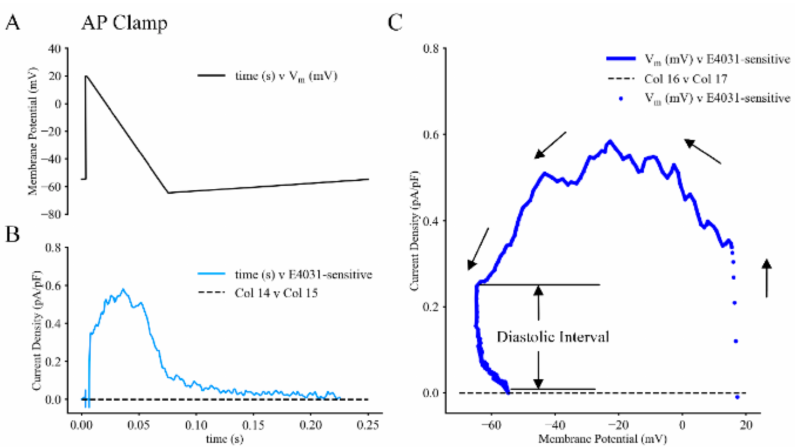
Figure 4. Ramp Voltage Clamp Experiments Done in an Attempt to Reveal the Size and Kinetics of HERG Activation During the ‘Action Potential’ and/or its Deactivation During the Pacemaker Depolarization in Adult Mouse SAN Myocytes. Panel ( A ) shows the ‘AP’ voltage clamp ramp waveform. This was applied at 0.1 Hz from a holding potential of − 60 mV. The averaged current records in Panel ( B ) denote the activation and deactivation of HERG during the AP and subsequent slow pacemaker depolarization. The record in Panel ( B ) has been signal averaged and is based on current changes recorded from a total of six different SAN cells. Panel ( C ) is a phase plane plot (dV/dT vs. Vm) that denotes the average ( n = 10 traces) net E4031-sensitive current during re-polarization of the AP under control conditions (black) and after E4031